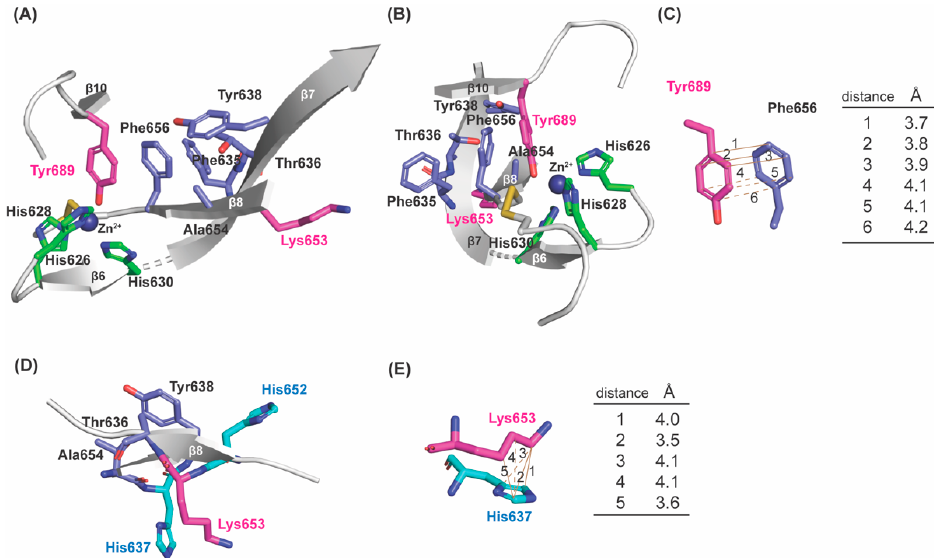
Figure 3. A hydrophobic patch is found in the active site of the precursor LOXL2 structure (PDB: 5ZE3). ( A ) Phe635, Thr636, Tyr638, Ala654, and Phe656 comprise a hydrophobic patch and that seems to stabilize the short β− sheet ( β 8) in an unproductive conformation. Consequently, Lys653 is in the orientation to face away from Tyr689 to prevent the LTQ formation. ( B ) The same structure as ( A ) from a different angle. ( C ) Tyr689 and Phe656 are in π – π stacking interaction and within Van der Waals radii. ( D ) and ( E ) In addition, Lys653 is in hydrophobic interaction with His637.